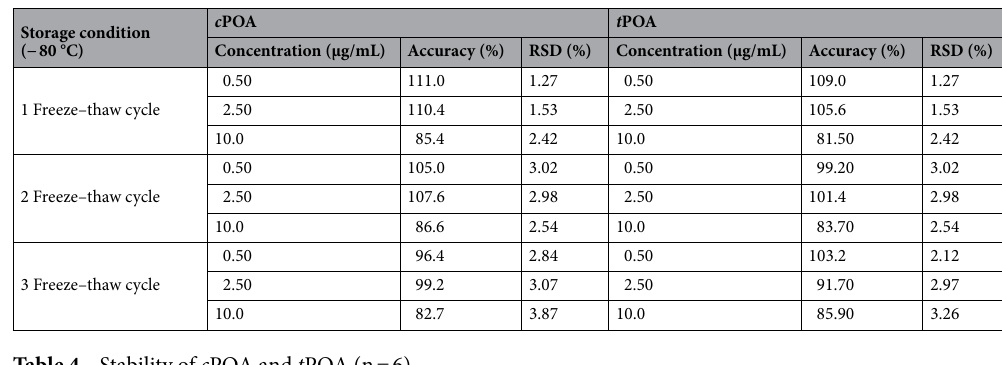
Table 4. Stability of c POA and t POA (n = 6).